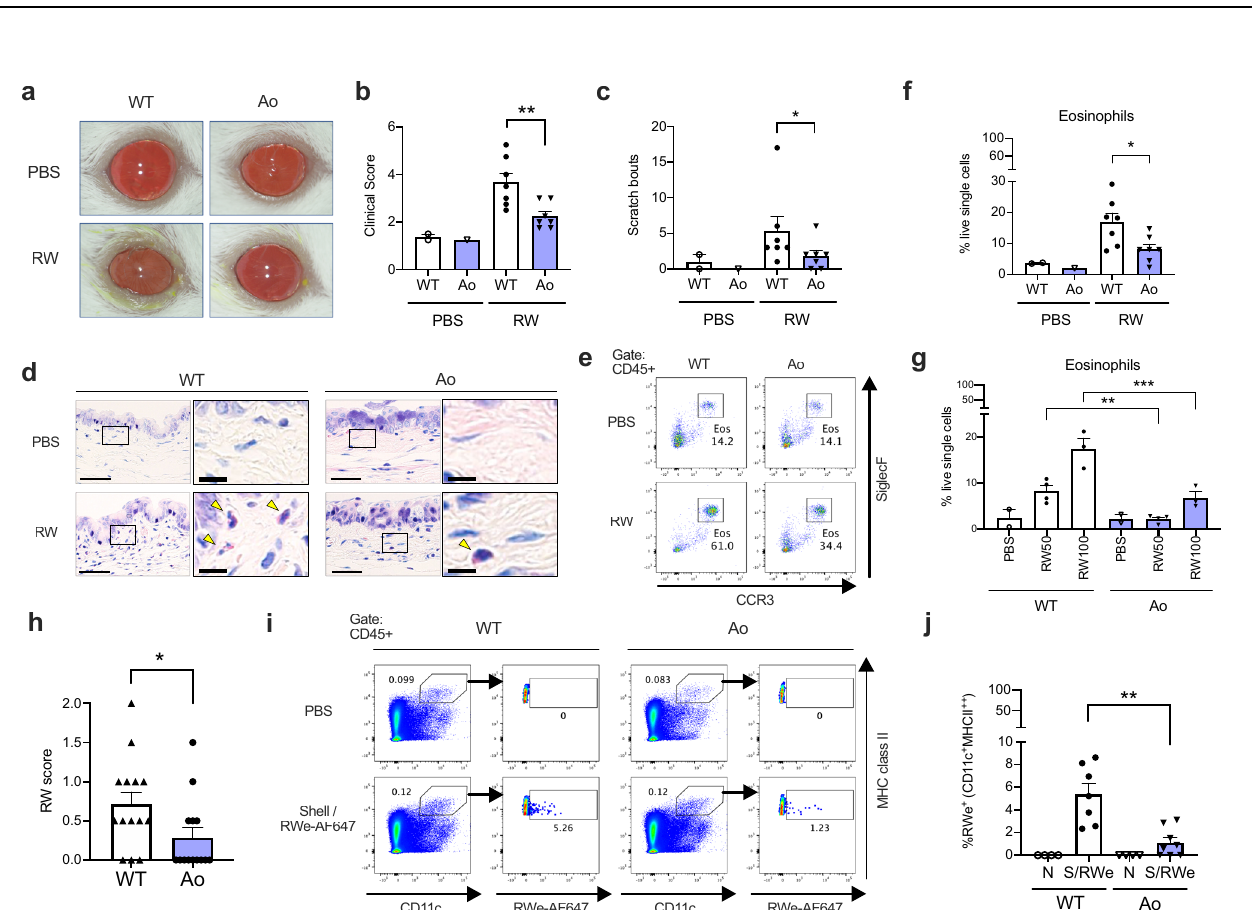
Fig. 8 | St6galnac1 protects mice against allergic conjunctivitis. a Clinical appearanceofPBS-orragweedpollen(RW)-challengedeyes. b Clinicalscores. n =2, 1,7,and7forPBS-WT,PBS-Ao,RW-WT,andRW-Aoconditions,respectively( b , c , f ). ** p <0.01( p =0.0093)by two-tailed Mann – Whitney test. c Scratchbouts. * p <0.05 ( p =0.0449) by two-tailed Mann – Whitney test. d Giemsa staining of the con- junctiva. Arrowheads indicate eosinophils. Bar, 50 μ m. Inset: Bar, 10 μ m. e Eosinophil frequency among CD45+cells in the conjunctiva. Eosinophil fre- quencies in live single cells after challenges of 100mg/mL ( f ) or indicated amount (mg/mL) ( g ) of RW pollen or PBS. * p <0.05 ( p =0.0379) by two-tailed Mann – Whitney test ( f ). ** p <0.01 (adjusted p =0.0091, WT vs Ao in RW 50mg/mL condition), *** p <0.001 (adjusted p =0.0006, WT vs Ao in RW 100mg/mL condi- tion) by two-tailed ANOVA with Holm-Sidak ’ s multiple comparisons test ( g ). h RW